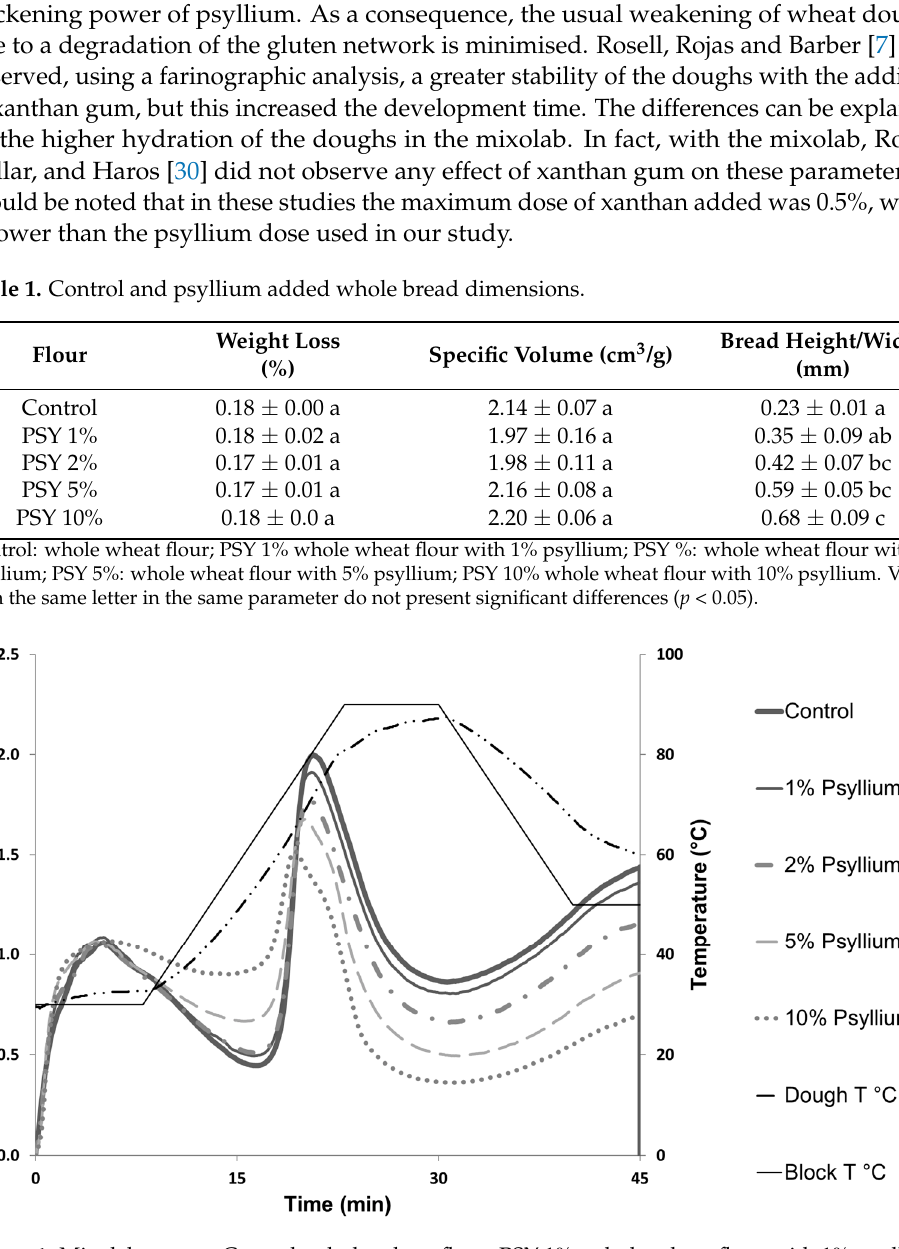
Figure 1. Mixolab curves. Control: whole wheat flour; PSY 1%: whole wheat flour with 1% psyllium; PSY 2%: whole wheat flour with 2% psyllium; PSY 5%: whole wheat flour with 5% psyllium; PSY 10%: whole wheat flour with 10% psyllium. Table 1. Control and psyllium added whole bread dimensions.